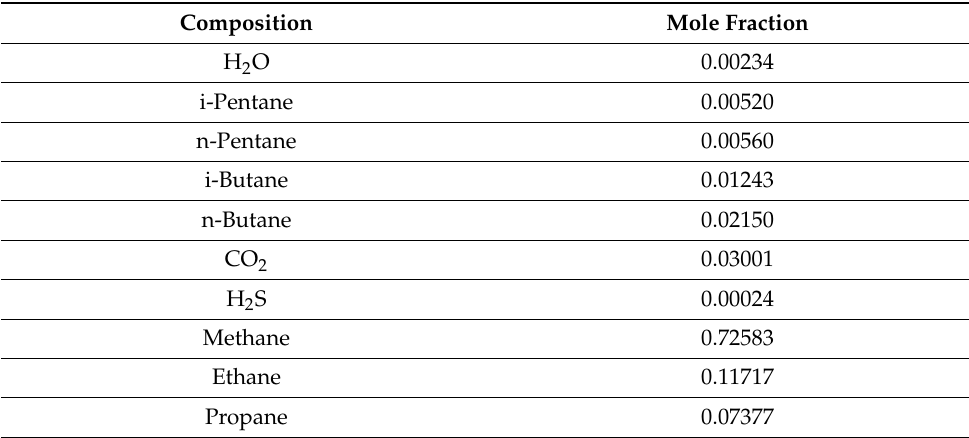
Table 1. Sour feed gas composition used for the simulation.